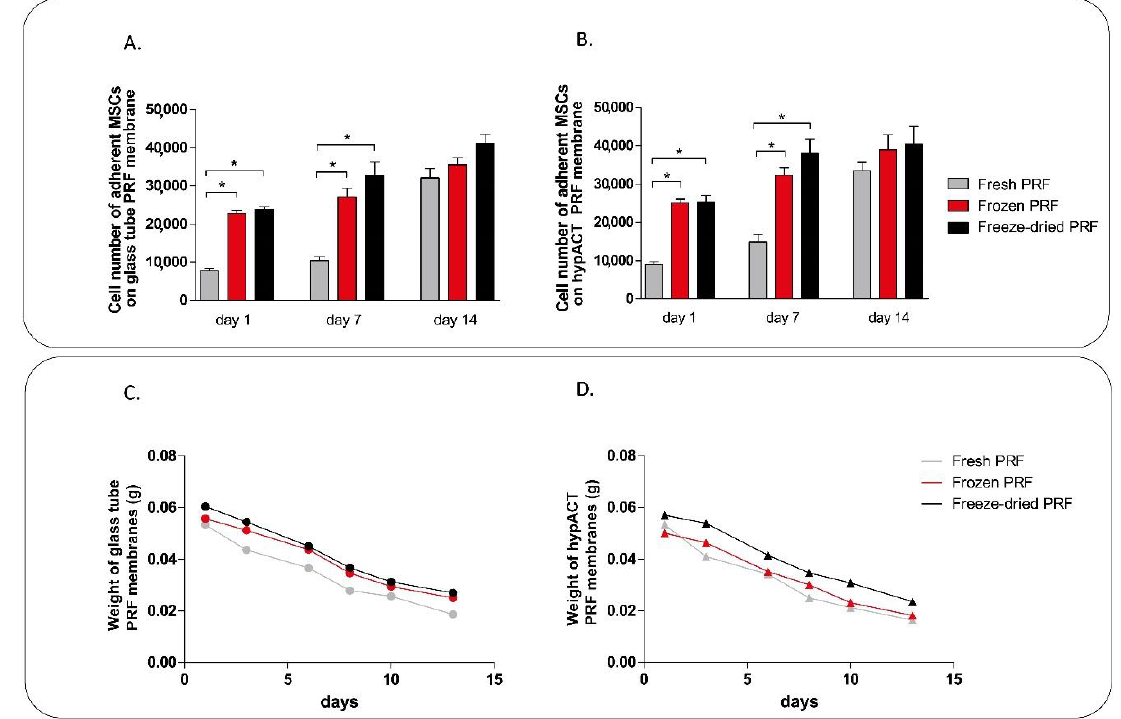
Figure 6. The adhesion and proliferation capacities of mesenchymal stem cells cultured on PRF membranes ( A , B ) and weight loss of the membranes ( C , D ) during the culture period. Mesenchymal stem cells were seeded onto fresh, frozen, and freeze-dried GT and HI PRF membranes in 24 well low attachment plates. Significant differences ( p < 0.05) were marked by *.